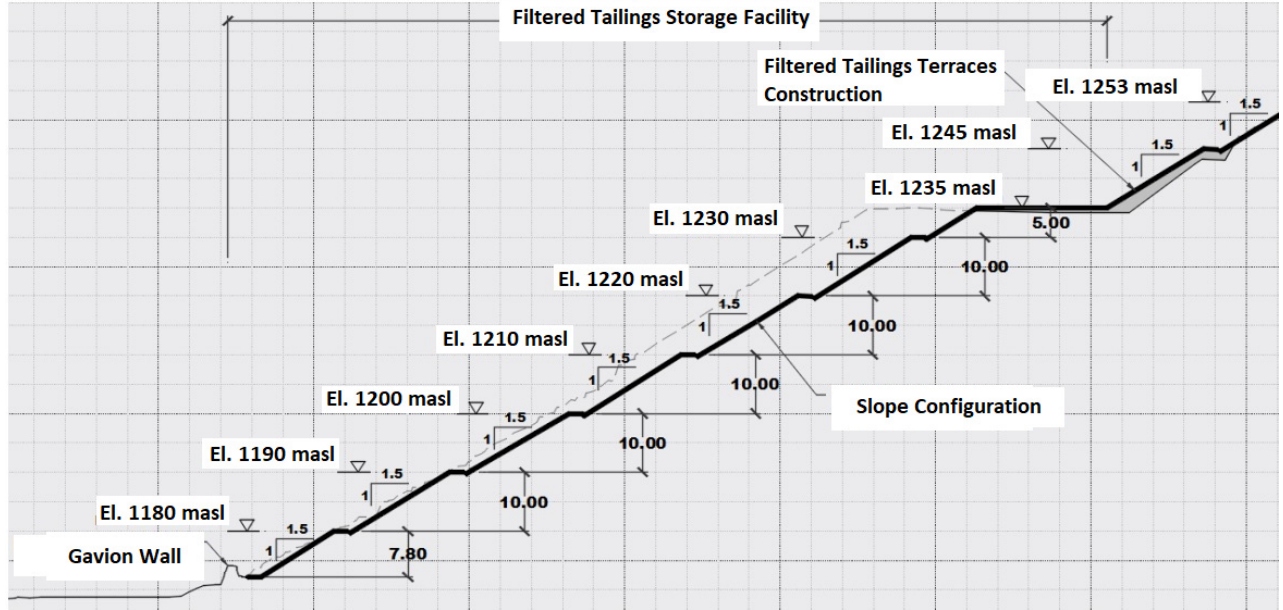
Figure 61. Poderosa Typical Cross Section Filtered Tailings Storage Facility [36,37].